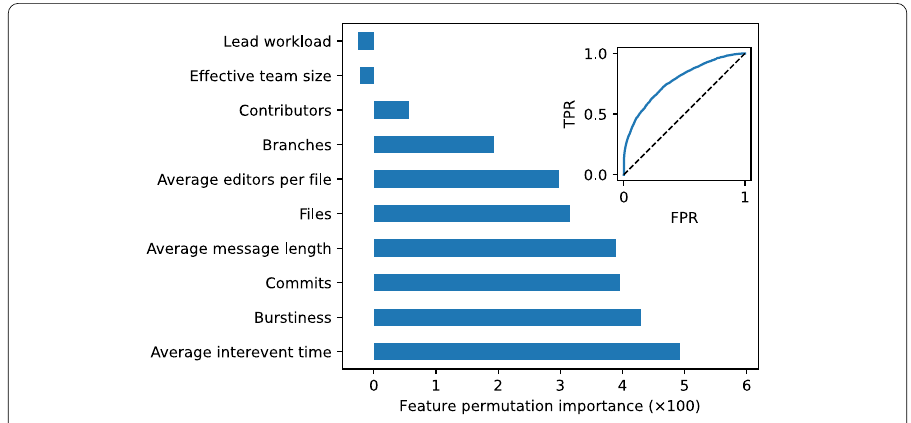
Figure 6 Random forest model to delineate Penumbra and GitHub samples. Feature permutation importance (Sect. 2.5) once nonlinear random forest regressions were trained to predict whether a project was on GitHub or in the Penumbra. The predictive performance is shown in the inset using an ROC curve of true positive rate (TPR) and false positive rate